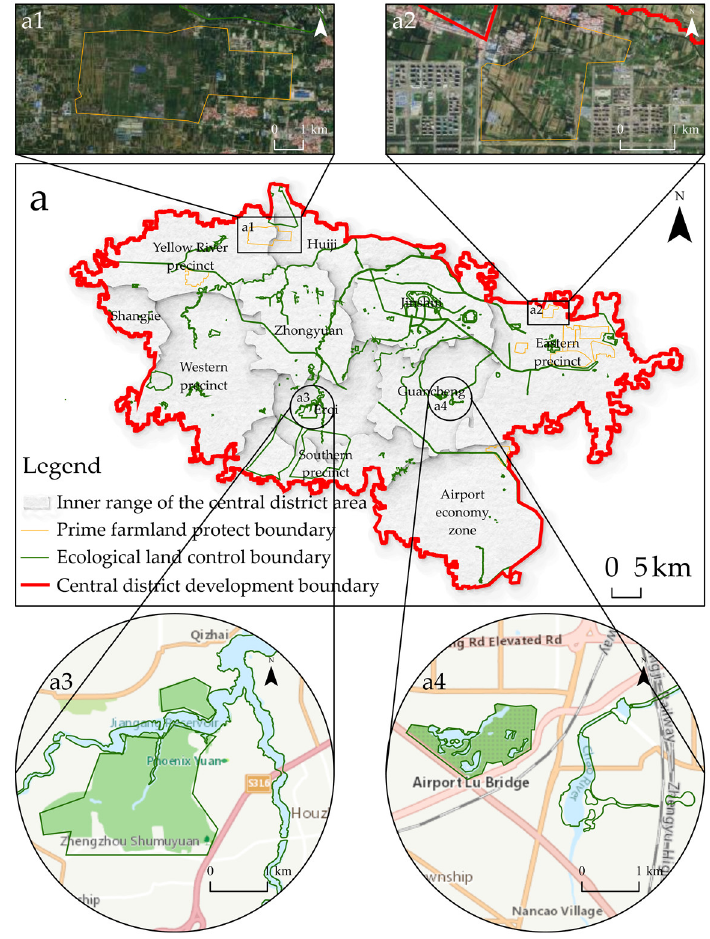
Figure 8. Optimization analysis of the development boundary of the central district. Table 9. Comparison of the development boundary of the central district area before and after op- timization.